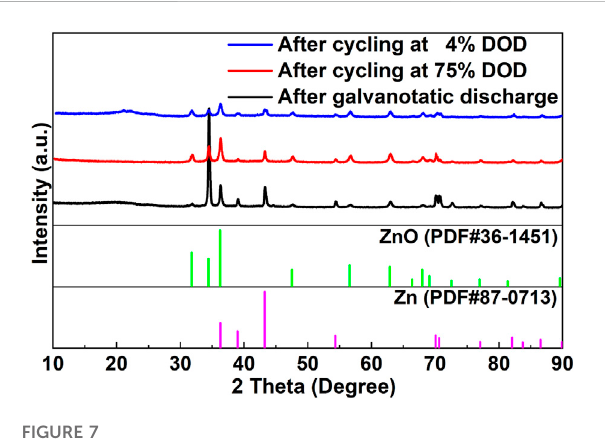
FIGURE 7 XRD results of the Zn anodes after galvanostatic discharge and cycling,